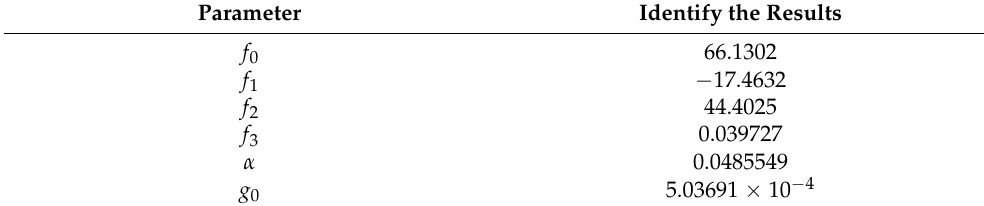
Table 1. Improved artificial fish swarm algorithm whole segment identification model parameters.